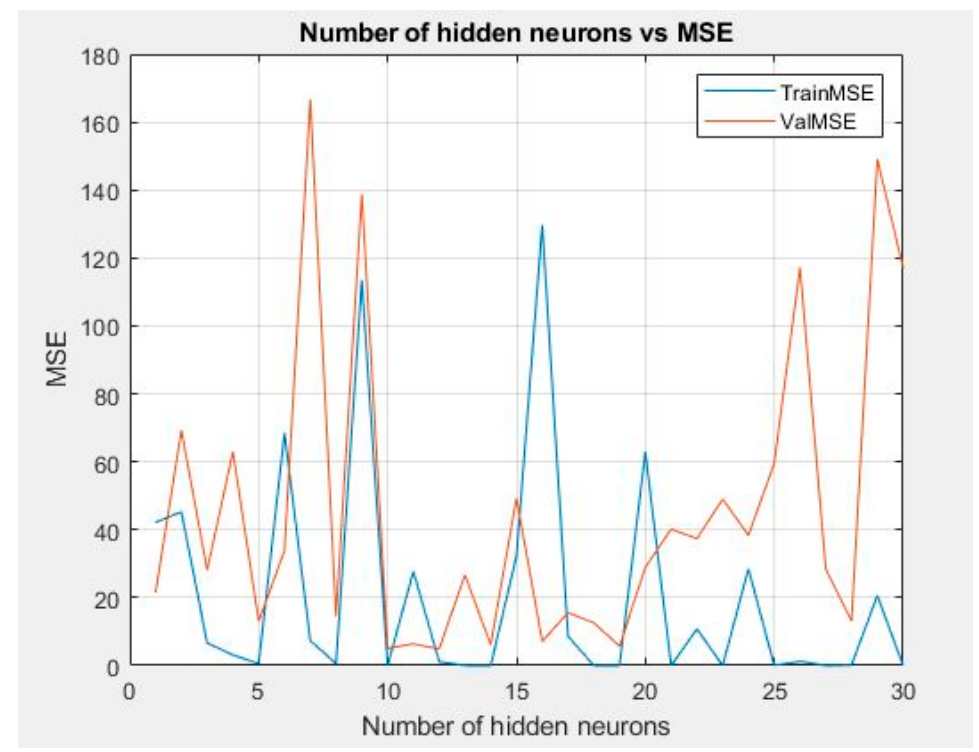
Figure 1. MSE vs number of hidden neurons. Figure 1. MSE vs. number of hidden